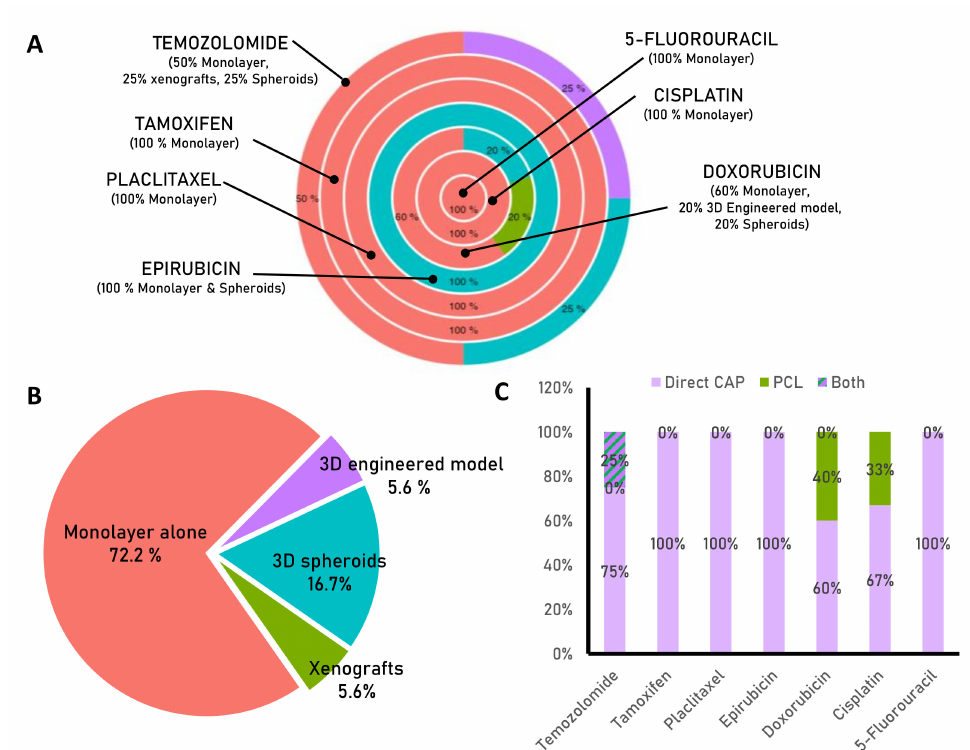
Figure 3. Statistics of studies related to CAP combined with pharmaceuticals. ( A ) The pie chart shows the percentage of trials conducted in monolayer, 3D models, or in vivo for each drug indicated. ( B ) The pie chart indicates the percentage of studies conducted in vitro using monolayer cultures (72.2%), and less than 6% using xenografts or 3D-engineered models. ( C ) The bar chart shows the percentage of studies that employed direct or indirect application of CAP for each drug. Most of the experiments in the literature have used CAP treatments combined with drugs, mainly in monolayer